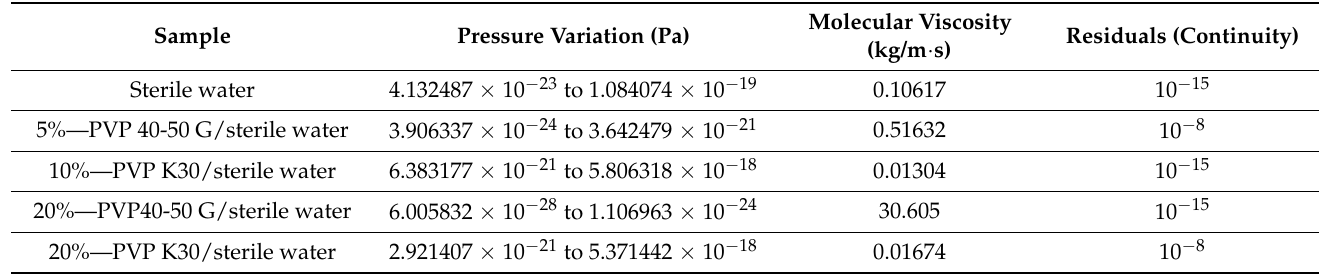
Table 4. Pressure and molecular viscosity values in each of the samples.